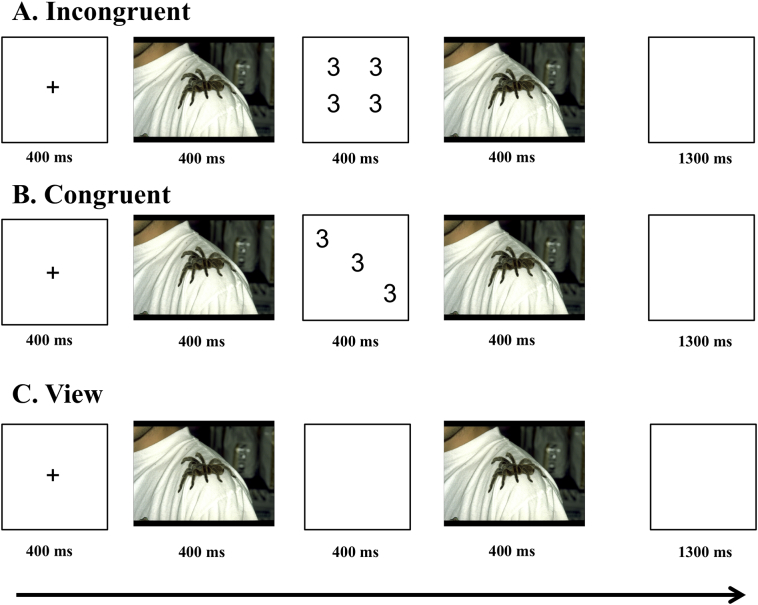
Diagram of aST for a trial with a negatively valenced stimulus. The (A) first row indicates an incongruent trial, the (B) second row indicates a congruent trial, and the (C) third row indicates a view trial.